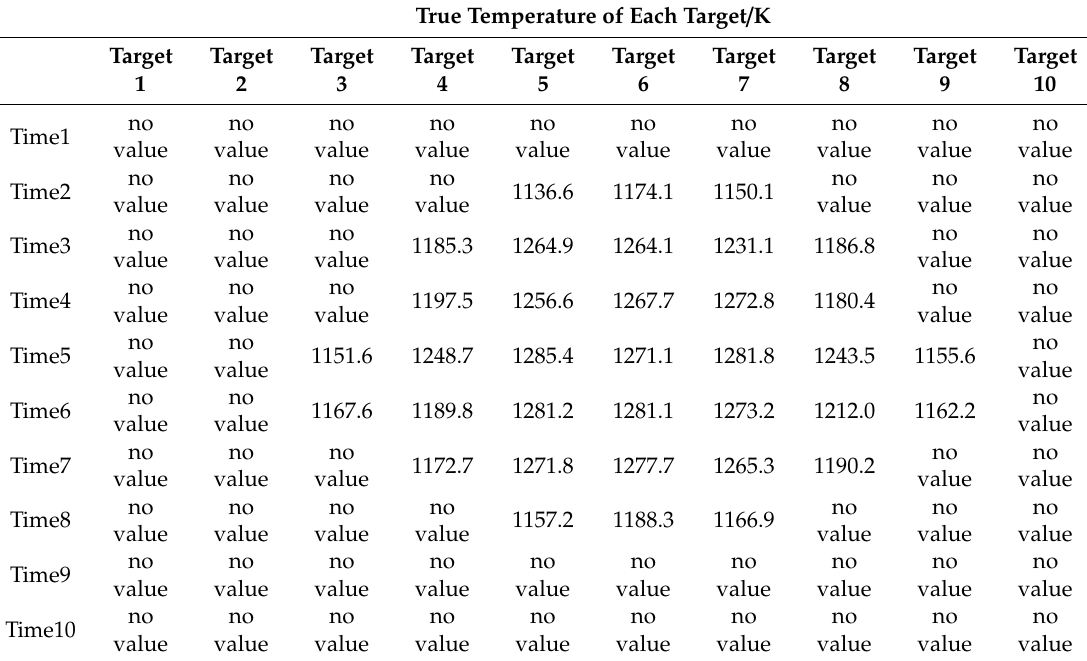
Table 3. The true temperature operation time.